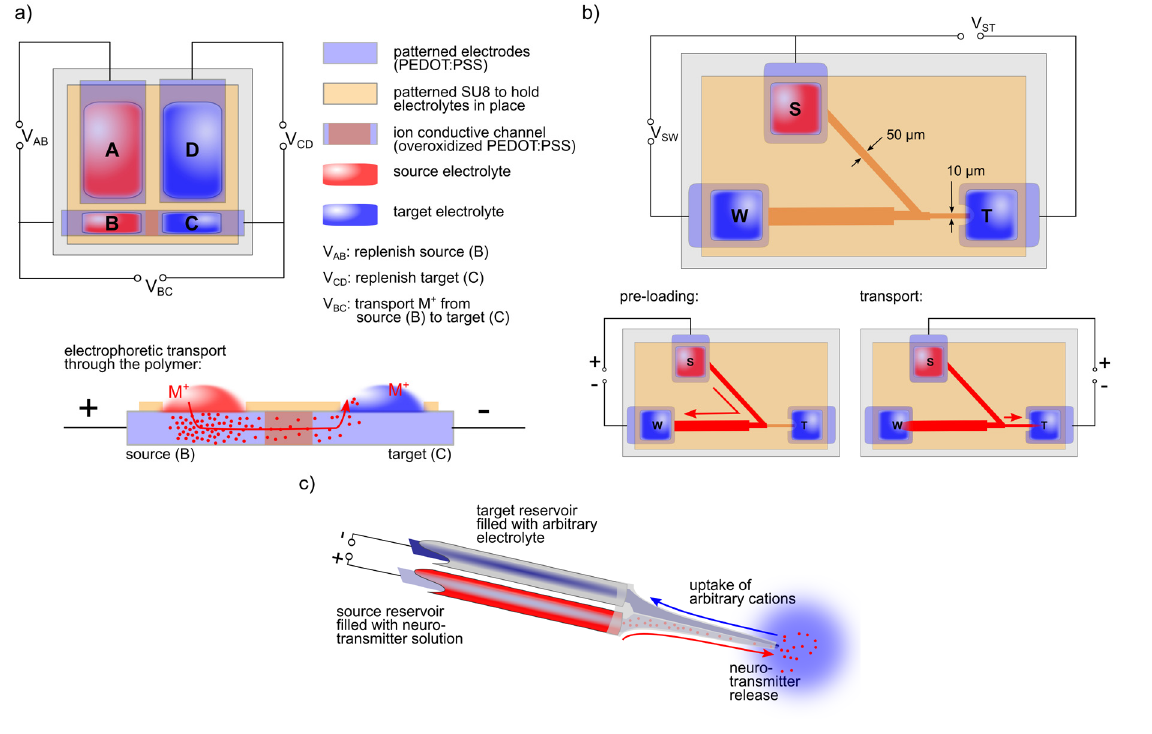
Figure 1. Electronically controlled ion transport using OEIPs. ( a ) Four PEDOT:PSS electrodes (A–D) are shown with electrolyte reservoirs held in place by a thin layer of SU8. The source (B) and the target (C) electrodes are connected by an overoxidised PEDOT:PSS channel. Two larger electrodes (A and D) are used to replenish the smaller electrodes (B and C); ( b ) The OEIP layout is changed to accommodate three PEDOT:PSS electrodes, source (S), waste (W) and target (T). A pre-loading circuit is created to enable tight spatiotemporal control over the transport. For pre-loading the channel, source (S) and waste (W) electrodes are adressed. To rapidly initiate transport, source (S) and target (T) electrodes are addressed as shown in the transport circuit; ( c ) Syringe like OEIP suitable for implantation and in vivo experimentation. By addressing source and target electrodes immersed in the respective reservoirs, biomolecules are released from the tip of the device, which can be placed in direct contact with specific biological tissue or cell